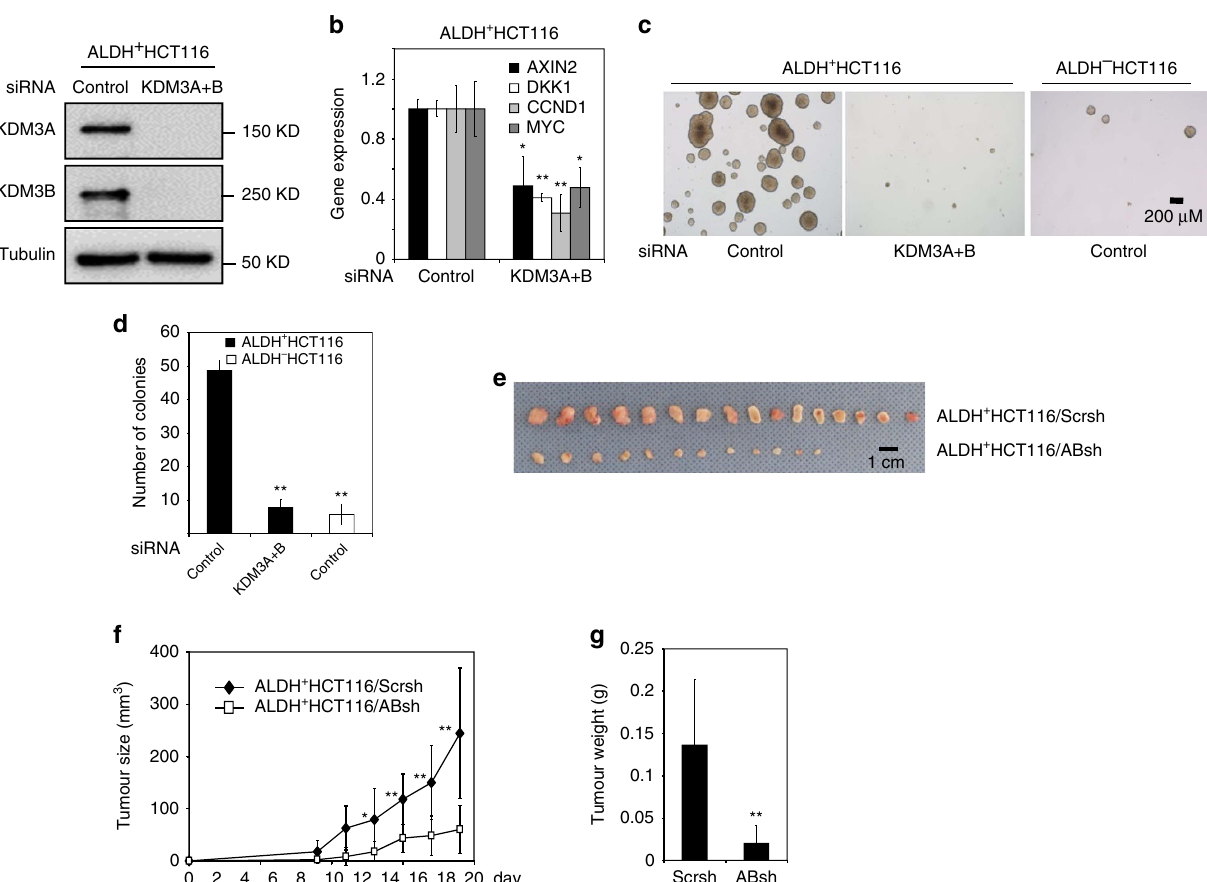
Figure 3 | KDM3A and KDM3B control the tumorigenic potential of CSC-like cells through Wnt/ b -catenin. ( a ) The knockdown of KDM3A/B by siRNA in ALDH þ HCT116 cells. ( b ) The knockdown of KDM3A/B inhibited the expression level of AXIN2 , DKK1 , CCND1 and MYC in ALDH þ HCT116 cells, * P o 0.05, ** P o 0.01, unpaired two-tailed student’s t -test ( n ¼ 3). ( c , d ) The Knockdown of KDM3A/B significantly inhibited tumorsphere formation of ALDH þ HCT116 cells. The number of spheres were counted from five different fields and averaged. The results represent mean ± s.d. from three independent experiments. * P o 0.05, ** P o 0.01, unpaired two-tailed Student’s t -test ( n ¼ 3). ( e , f ) The knockdown of KDM3A/B significantly inhibited tumorigenic potentials of ALDH þ HCT116 cells in vivo . Values are mean ± s.d. from a total of eight mice. * P o 0.05, ** P o 0.01, unpaired two-tailed Student’s t -test. ( g ) Comparisons of tumour weights at the end of experiments. * P o 0.05, ** P o 0.01, unpaired two-tailed student’s t -test ( n ¼